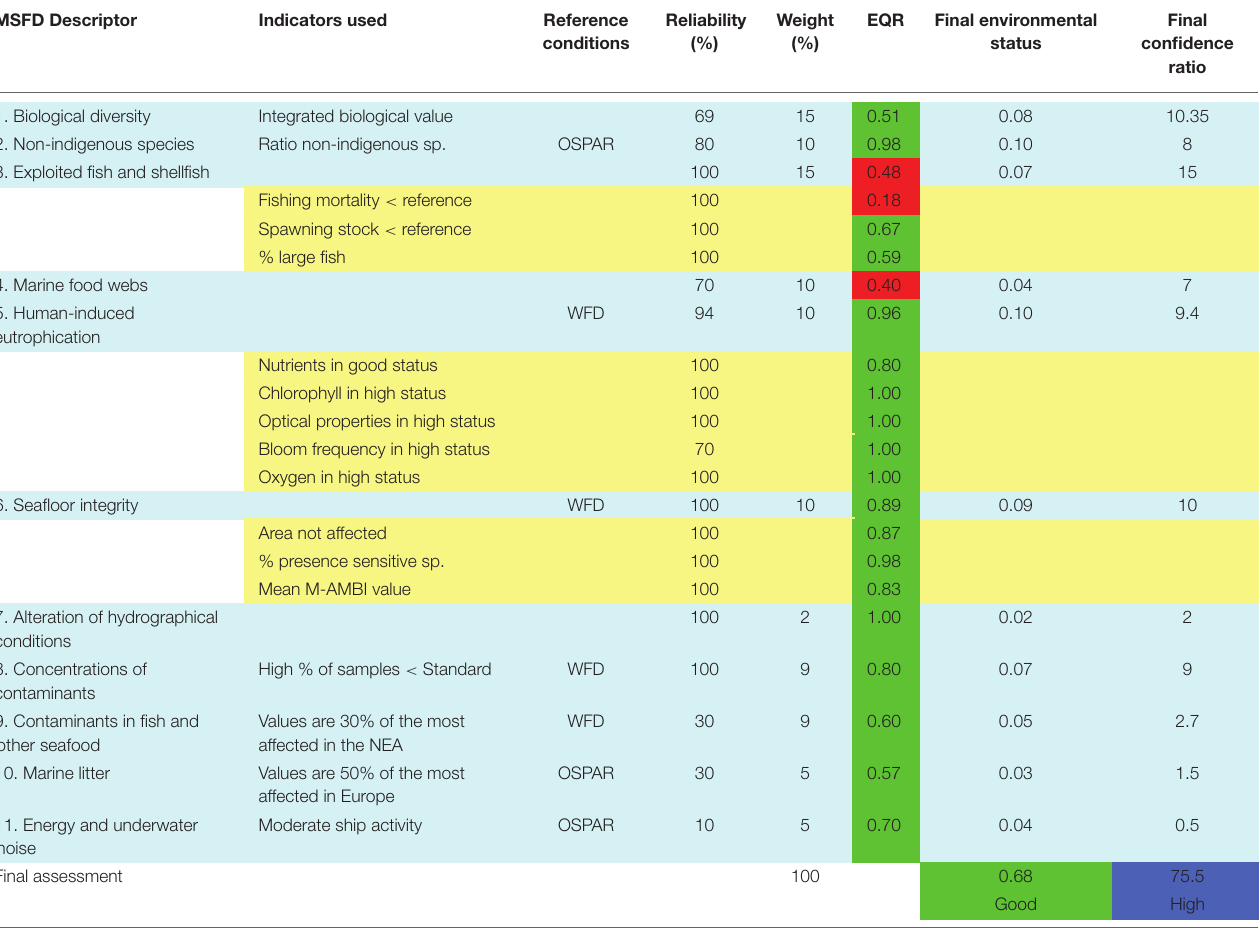
TABLE 2 | Example of an assessment of the environmental status, within the Marine Strategy Framework Directive, in the Bay of Biscay (modified from Borja et al., 2011). MSFD